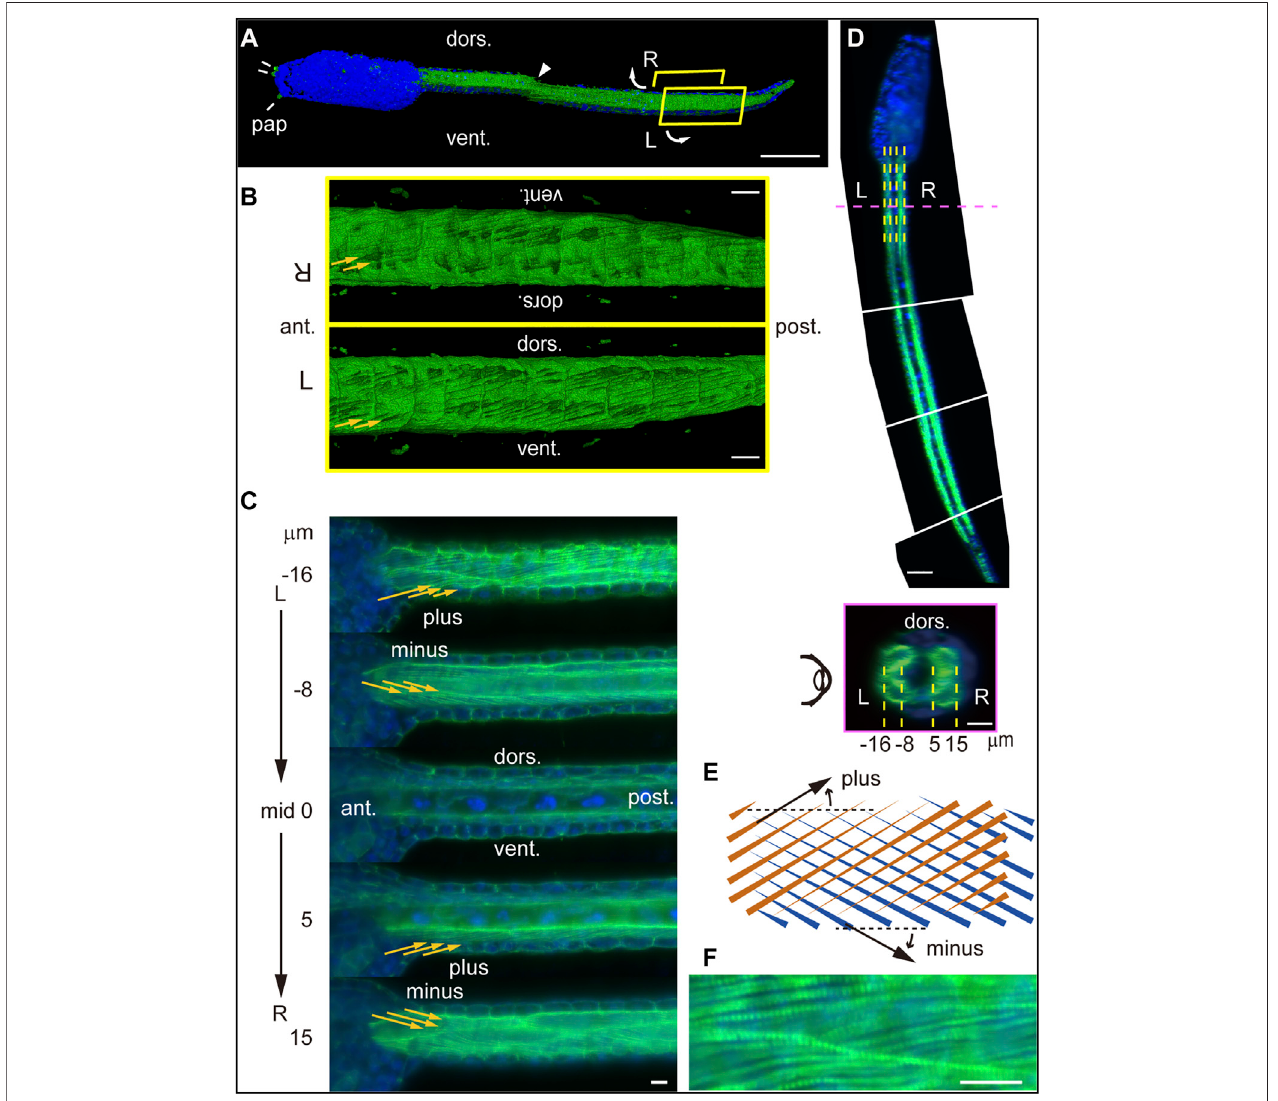
FIGURE3| Lightsheetmicroscopyanalysisofmyo fi brilorientationin Ciona tadpolelarvae. (A) Leftsideviewofanentire Ciona larvaat18 hpfstainedwithphalloidin (green) and DAPI (blue). pap, adhesive papillus. dors., dorsal. vent., ventral. Arrowhead indicates visible seam between two stitched 3D images. Curved arrows indicate ventral split of the tail shown in (B) . Scale bar, 50 μ m. (B) External view of phalloidin-stained tail within R and L yellow boxes in (A) . Yellow arrows indicate fi ne lines detected. Scale bar, 10 μ m. (C) Parasagittal sections (from top to bottom: − 16, − 8, 0, 5 and 15 μ m from the midsagittal plane). Scale bar, 10 μ m. (D) (top) Dorsal view of mid-horizontal plane of Ciona larva composed of four different images. Dashed yellow and magenta lines indicate positions of parasagittal- and cross-sections shown in (C) and (D) , respectively. Scale bar, 50 μ m. (bottom) Posterior view of a vertical cross-section. Dashed yellow lines indicate positions of parasagittal sections shown in (C) . Scale bar, 10 μ m. (E) Schematic microscopic views in front (brown) and back (blue) planes of fi ne lines angled in plus or minus orientations relative to the longitudinal axis of the tail. (F) Higher magni fi cation view of parasagittal section at the left lateral layer ( − 16 μ m from the midsagittal plane). Scale bar, 10 μ m.